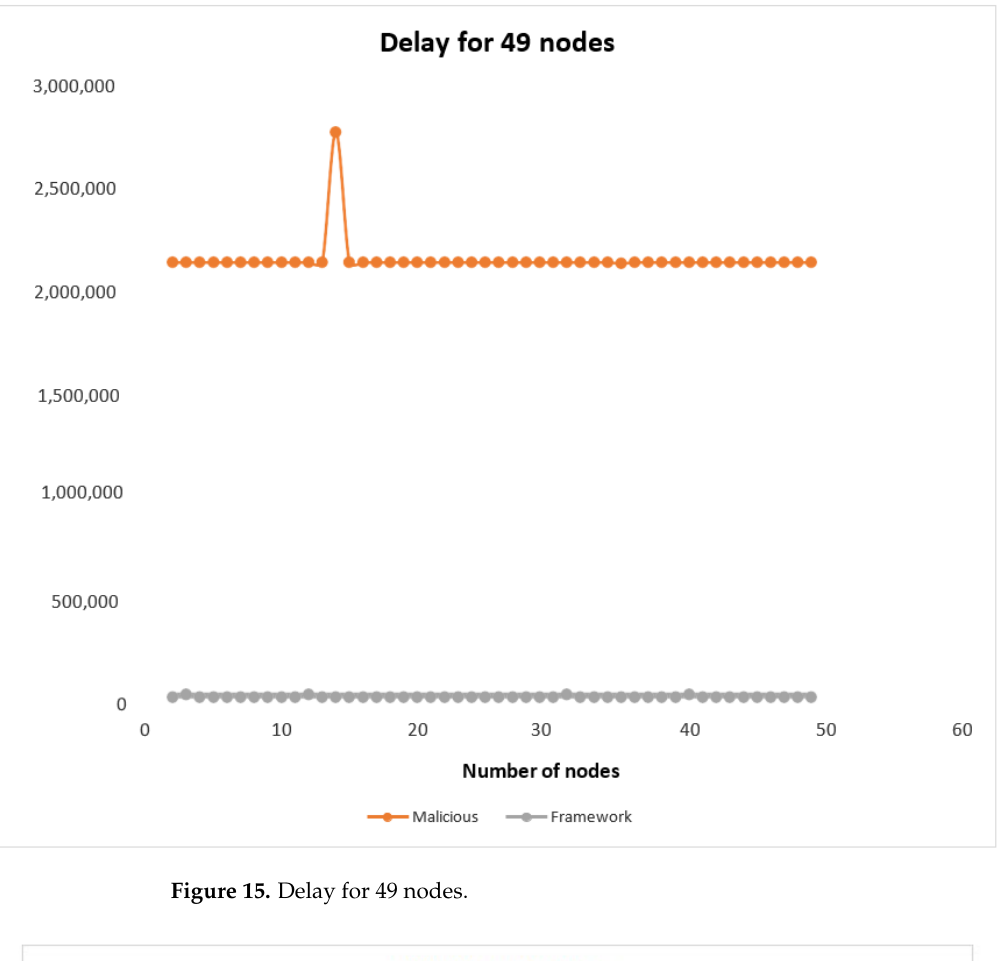
Figure 14. Throughput for sinkhole and framework scenarios.